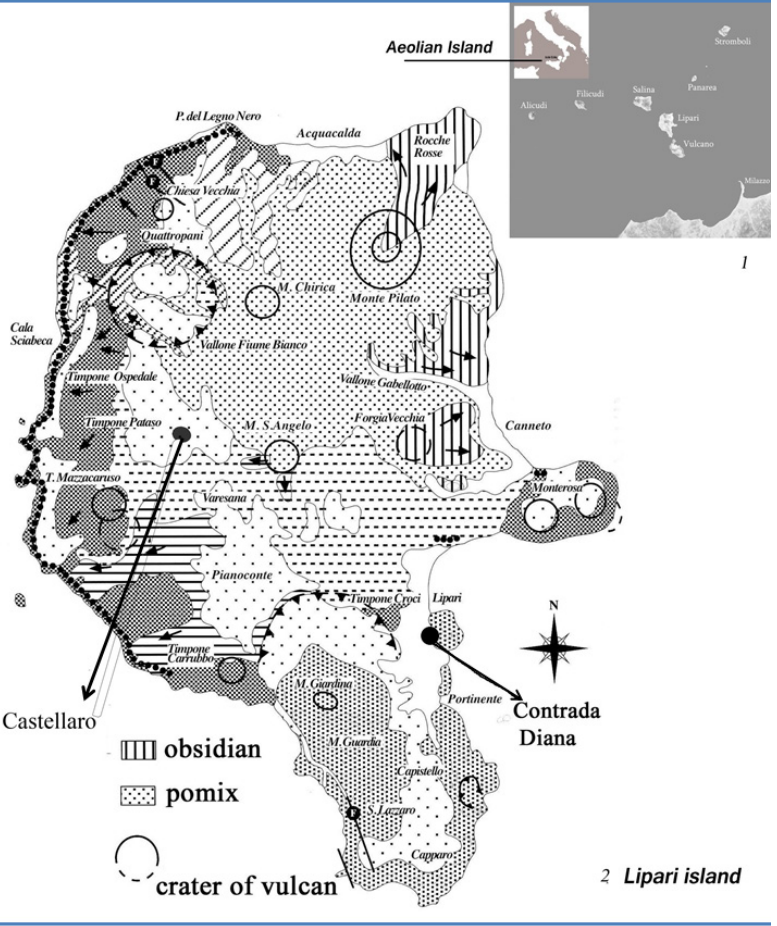
Figure 1. 1. Map Aeolian island and Italy. 2. Map obsidian flow in